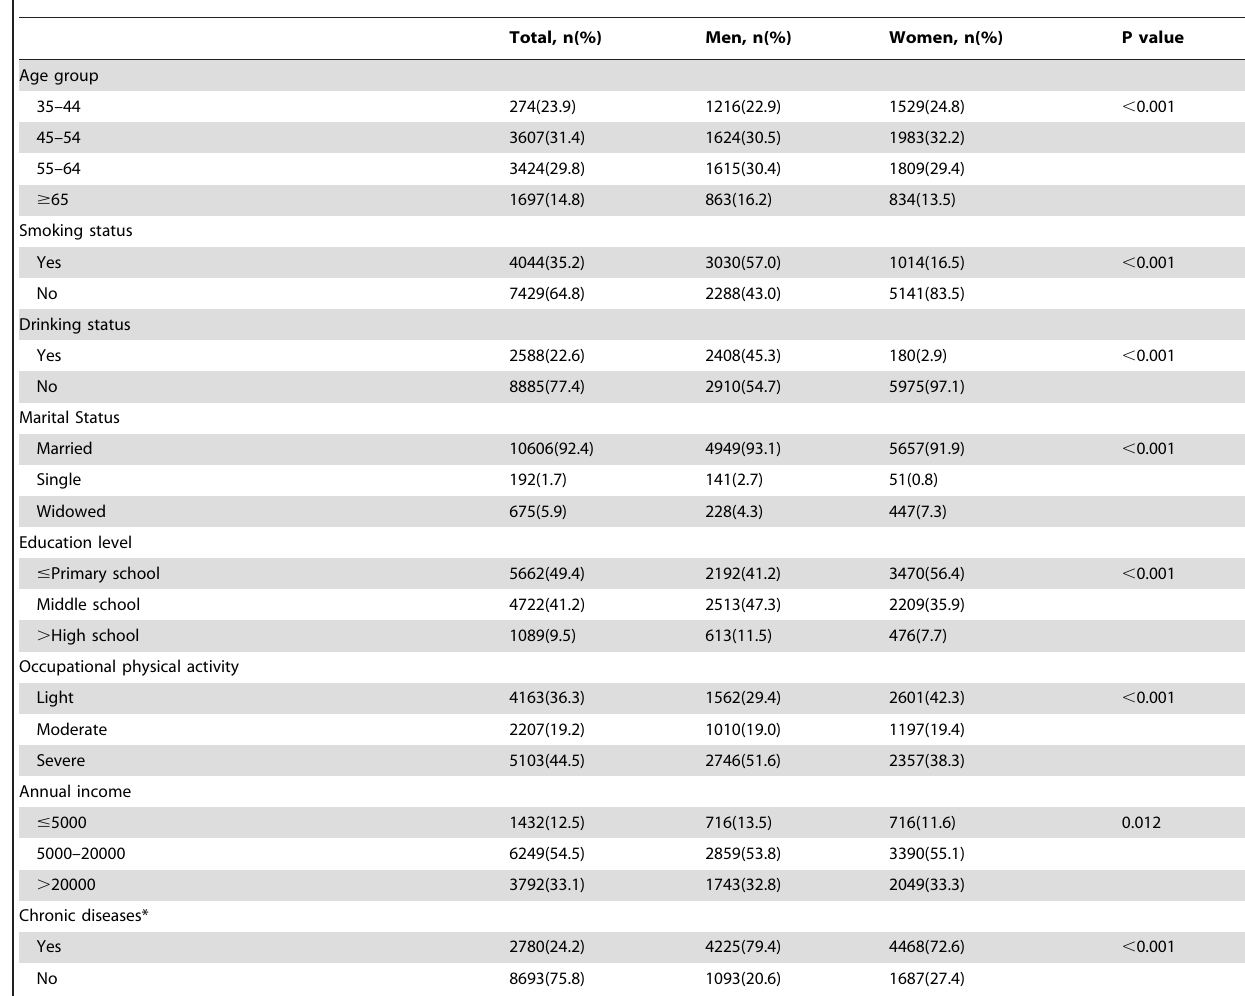
Table 1. General Characteristics of the Chinese Rural